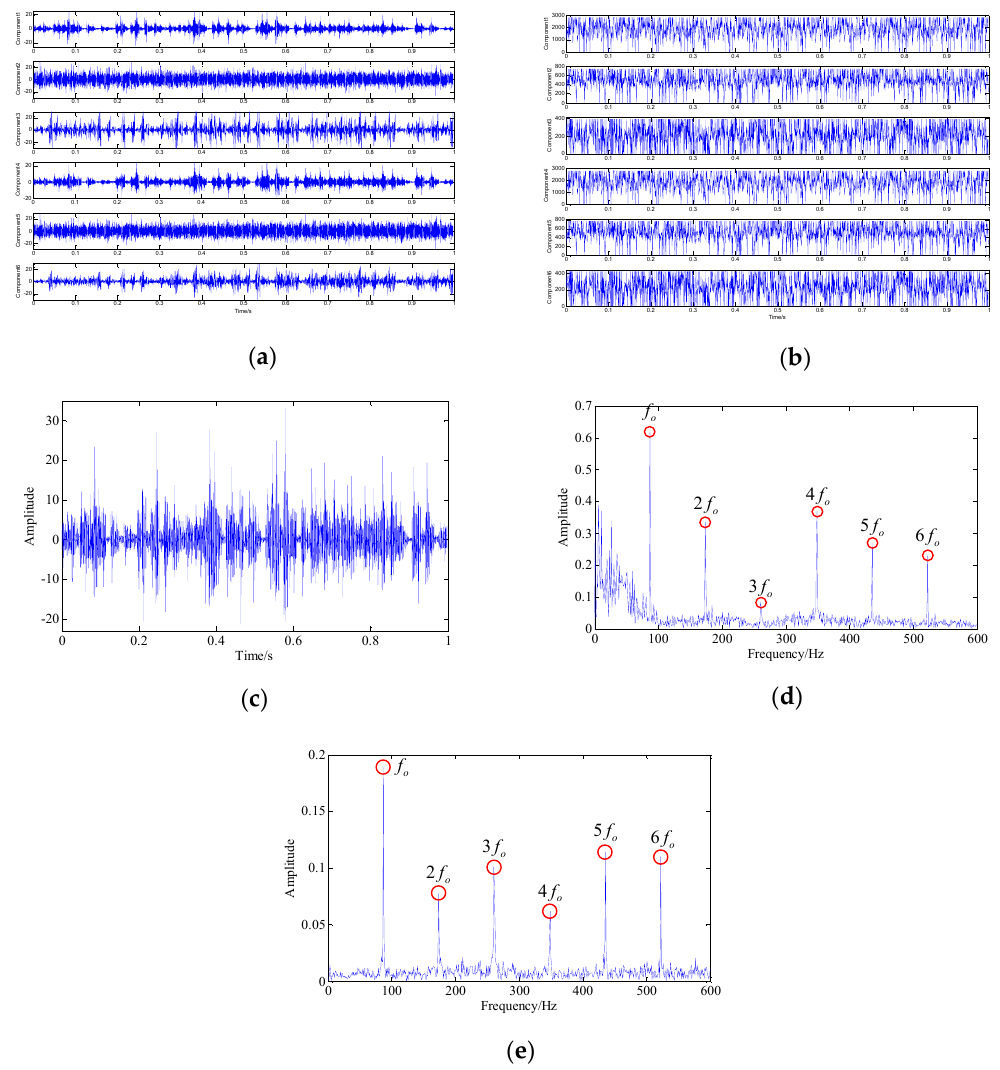
Figure 14. Analysis results of the proposed novel demodulation analysis technique: ( a ) waveforms of the one-dimensional single-component signals; ( b ) instantaneous frequency waveforms of each component; ( c ) waveforms of extracted fault characteristic signal; ( d ) envelope spectrum of the extracted signal; ( f ) instantaneous frequency spectrum of the extracted signal.